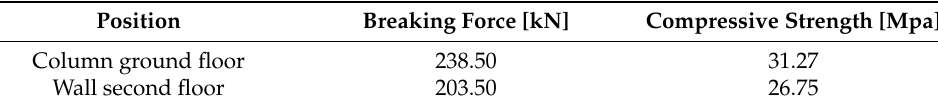
Figure 10. Samples after removal ( a ), after preparation for testing ( b ), and after testing ( c ). Table 3. Compressive strength of concrete in a column and a wall.